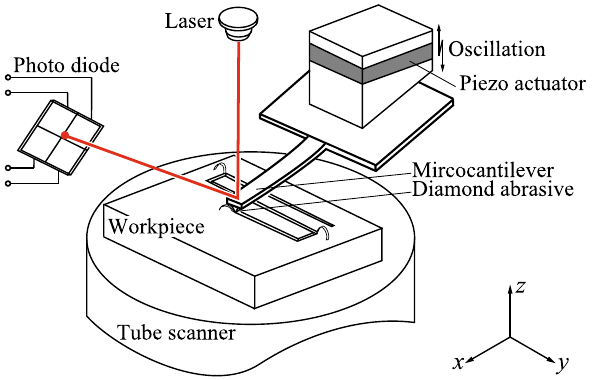
Figure 1. Schematic diagram of AFM system applied to nanoscale vibration cutting method. The system includes a workpiece, a microcantilever with a diamond set on its tip, a piezo actuator to enable the microcantilever oscillation, an optical lever consisting of a laser and a quadrant photodiode to measure the deflection of the microcantilever tip and a tube scanner to move the workpiece in the x - y plane and vary the distance between the microcantilever and the workpiece in the z -direction.